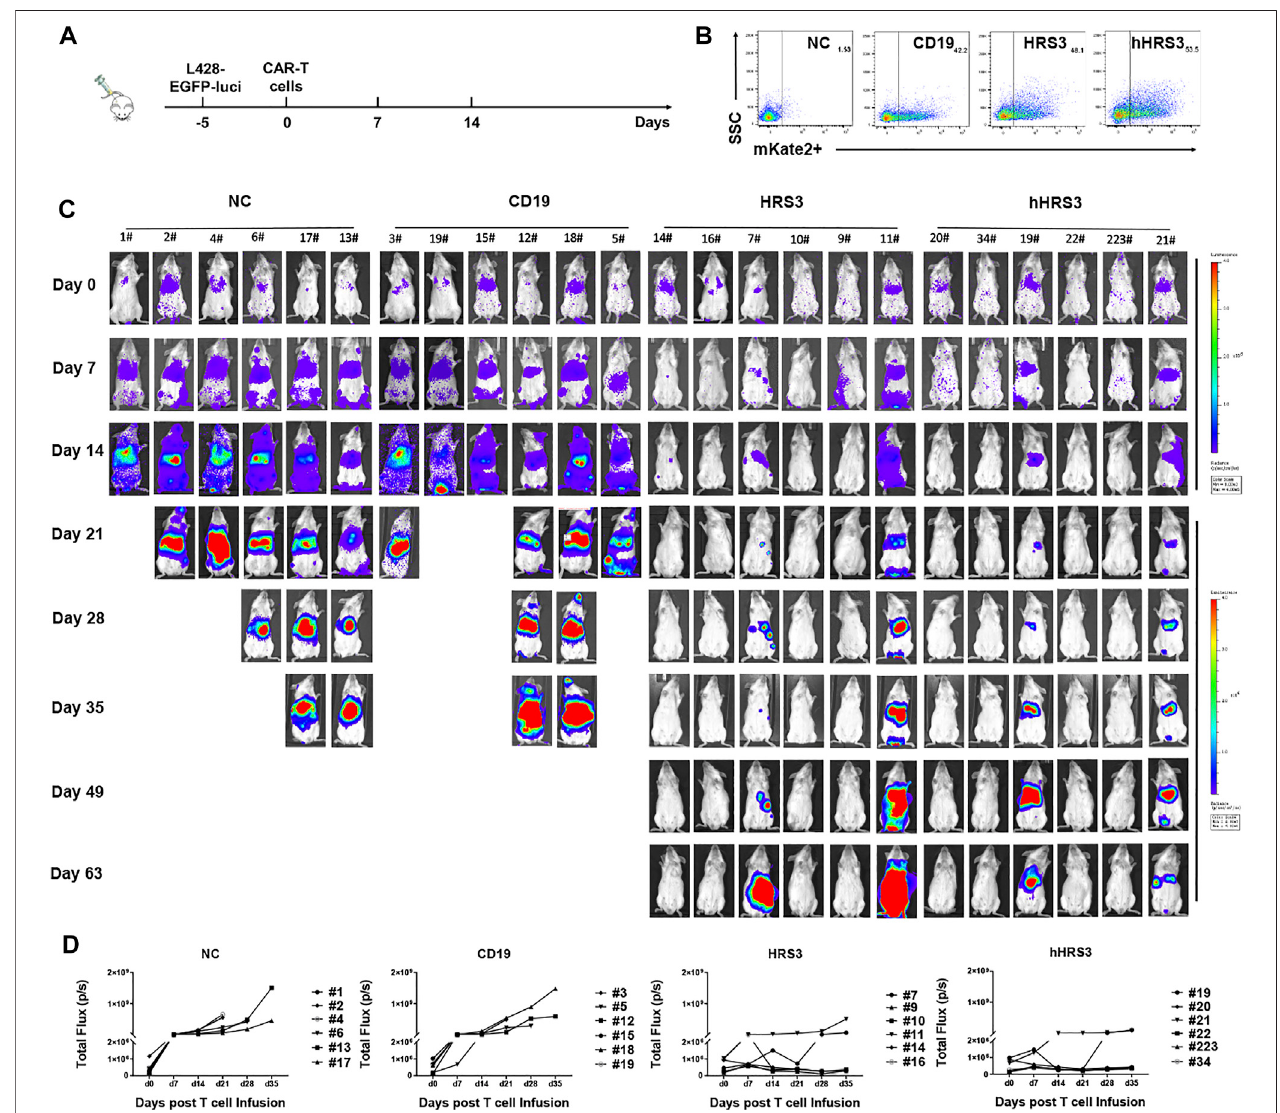
FIGURE 4 | Humanized HRS3-CAR-T cells eradicate tumors in vivo . (A) The panel shows the in vivo xenograft immunode fi cient mouse model in which HL L428- EGFP-luci cells (2 × 10 6 cells per mouse) were systemically infused into NCG mice ( n (cid:1) 6 for both experimental and control groups, day -5). Effector cells or un- transducedTcells(1 × 10 7 cellspermouse)wereinfusedintravenouslyatthetimeoftumorestablishment(day0),whichwasassessedbyIVISImaging. (B) Expressionof CAR-T in each group inoculated. (C) IVIS Imaging of tumor growth from day 0 to day 63 (end-of-imaging). (D) Bioluminescence of each mouse xenograft treated withNC Tcells,CD19-CAR-Tcells,HRS3-CAR-Tcells,and hHRS3-CAR-T cells.Eachexperimentincluded 6micepergroupand wasrepeatedtwice(total n (cid:1) 12mice per group). Data are representative of two independent